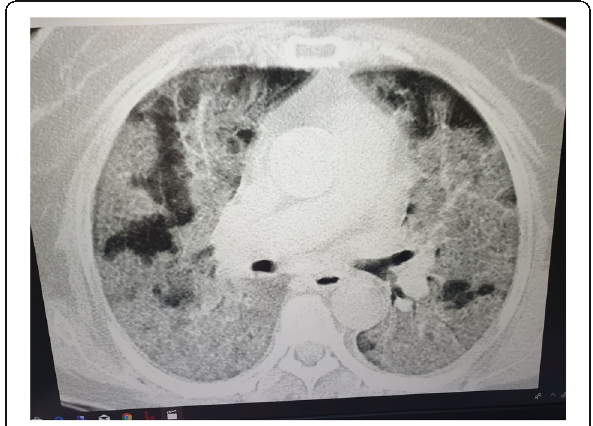
Fig. 1 Typical bilateral peripheral ground-glass opacity (GGO) and crazy paving appearance Fig. 2 Lobes and segments of both